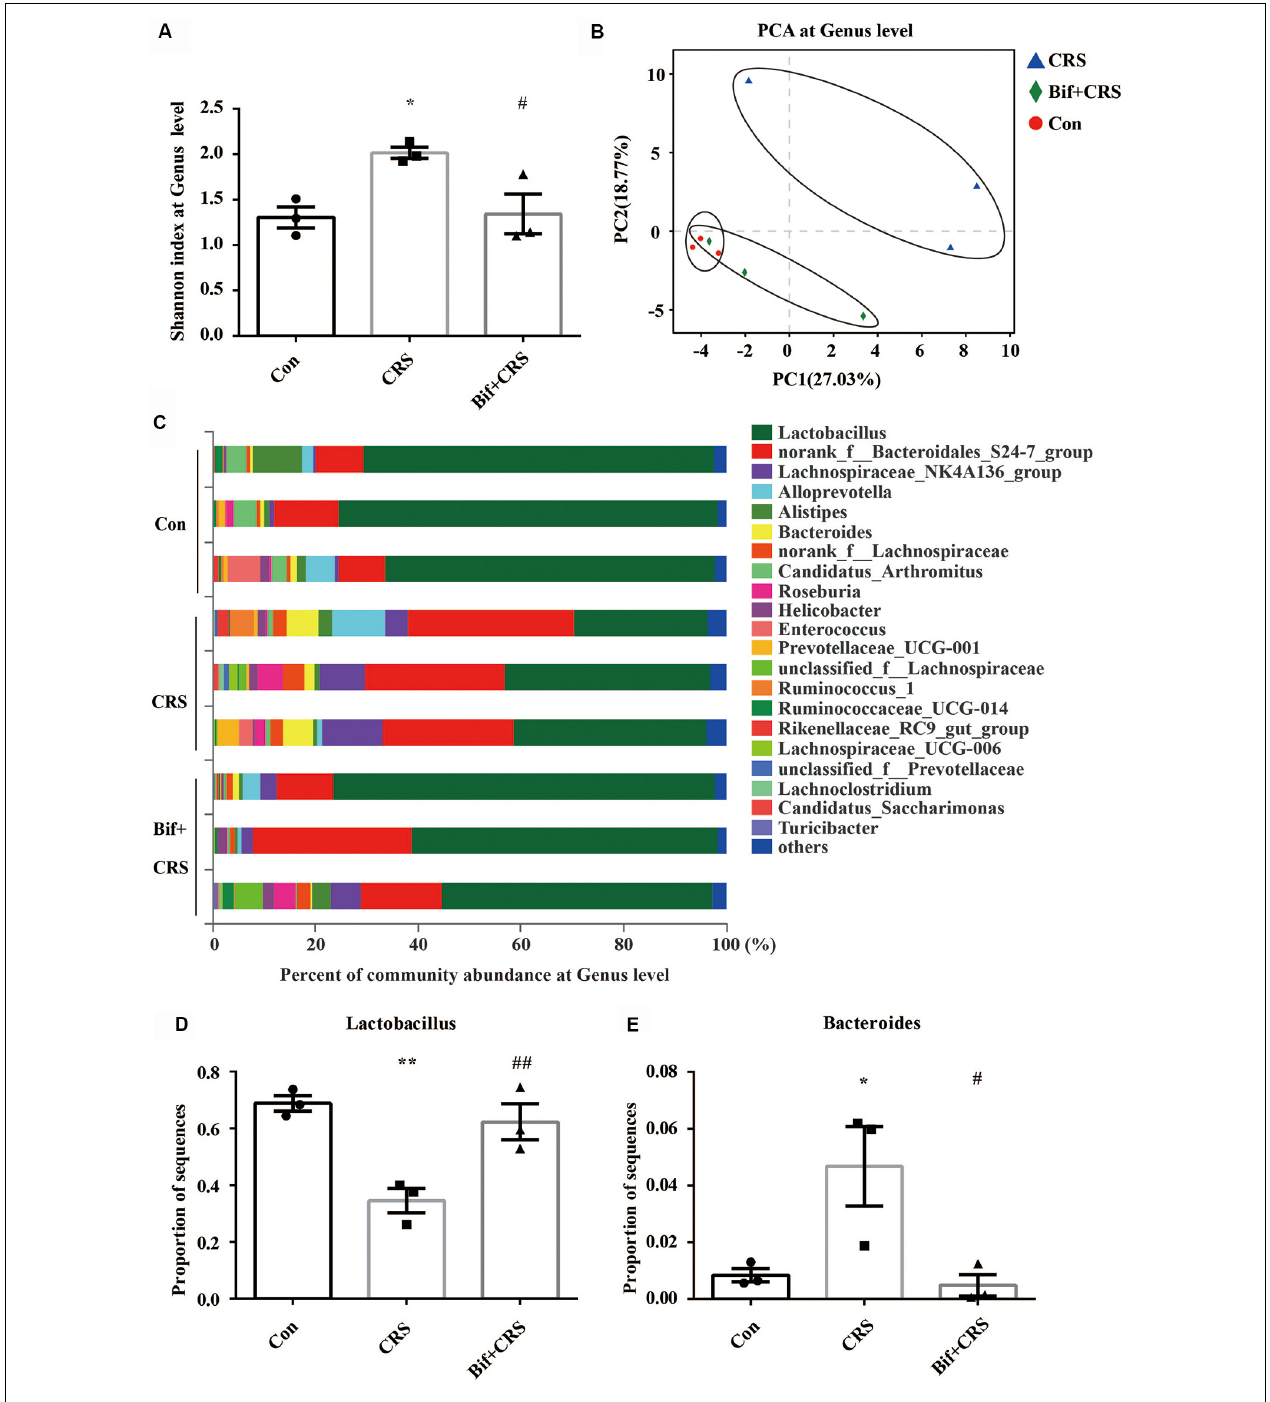
FIGURE 4 | B. adolescentis reversed the imbalance of the intestinal microflora induced by CRS at the genus level. The mice in the Con, CRS, and Bif+CRS groups were treated with 10 mL/kg distilled water, 10 mL/kg distilled water, and 0.25 × 10 9 CFU/kg B. adolescentis , respectively, by gavage for 21 days. (A) An increased Shannon index was observed in the CRS group compared with the control group, and the increase in the index was attenuated by B. adolescentis . (B) PCA revealed that the microbial community composition in the B. adolescentis group was more similar to that in the control than that in the CRS group, as shown by the clustering of the samples in the plots. (C) Community barplot analysis is shown. (D) The decrease in the Lactobacillus abundance in the CRS group was increased by B. adolescentis . (E) The enhanced Bacteroides abundance in the CRS group was reversed by B. adolescentis . The data are shown as the mean ± SEM. One-way ANOVA followed by the Student-Newman-Keuls test was used. ∗ p < 0.05 and ∗∗ p < 0.01 vs. the control; # p < 0.05 and ## p < 0.01 vs. the CRS group; n = 3 per group. Con, Control; CRS, chronic restraint stress; Bif+CRS, B. adolescentis + chronic restraint stress.